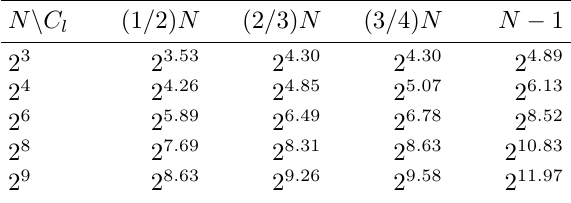
Table 12: Average number of queries such that a W-OTS + is recomputed for various cache sizes C l and different layers of N signatures. N \ C l (1 / 2) N (2 / 3)